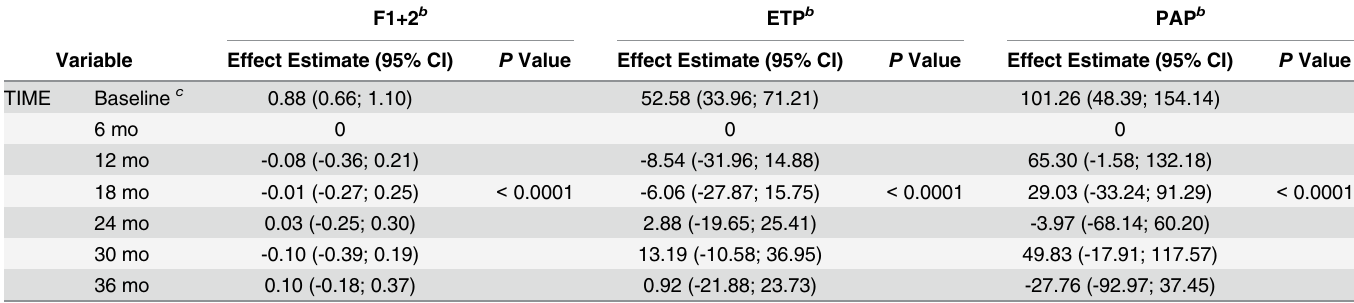
Table 3. Variations in hemostasis F1+2, ETP, and PAP during the follow-up of 50 treated patients.